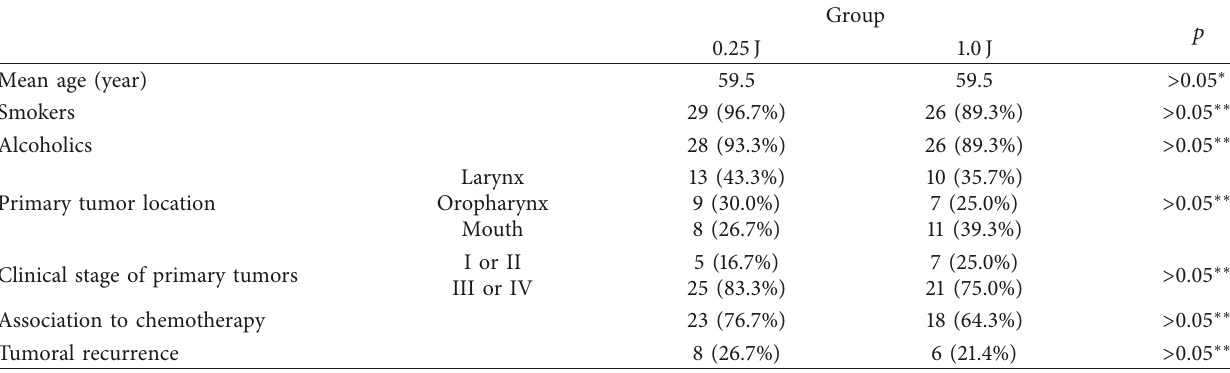
Table 3: Clinical features of the cases.